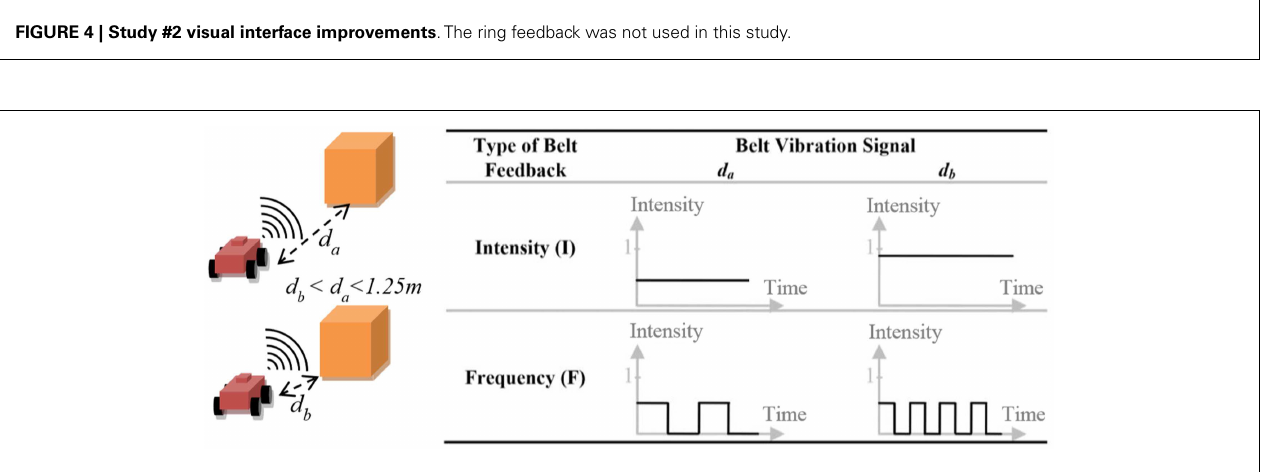
FIGURE 5 |Vibro-tactile modes evaluated in study #2